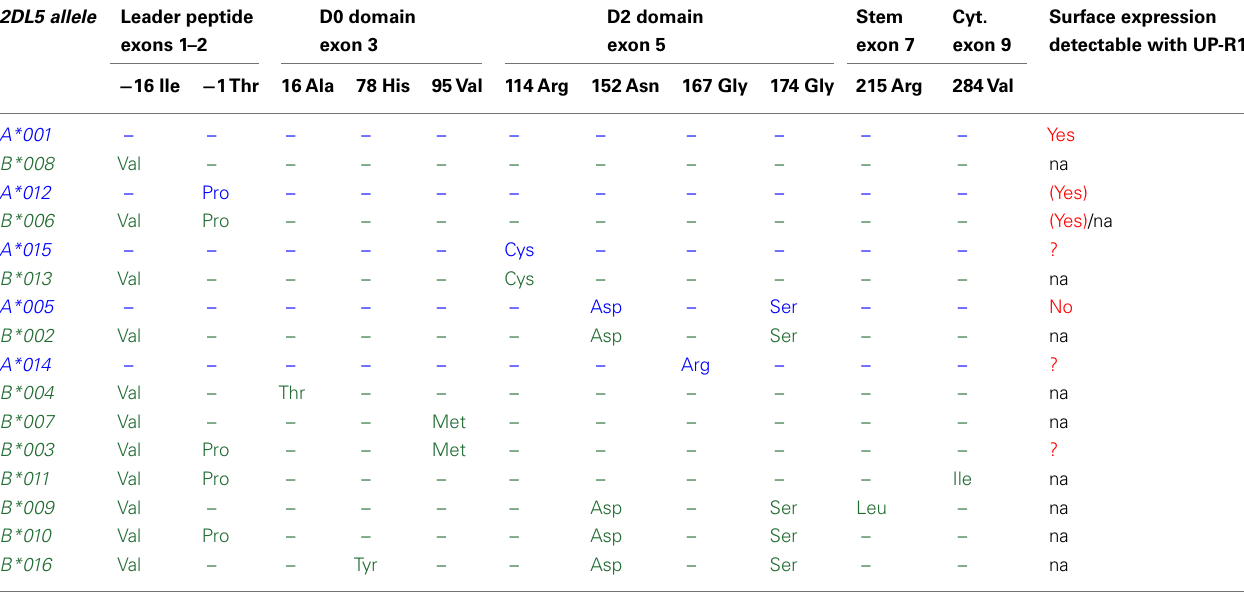
Table 2 | Comparison of the deduced primary structures and surface expression profiles of KIR2DL5